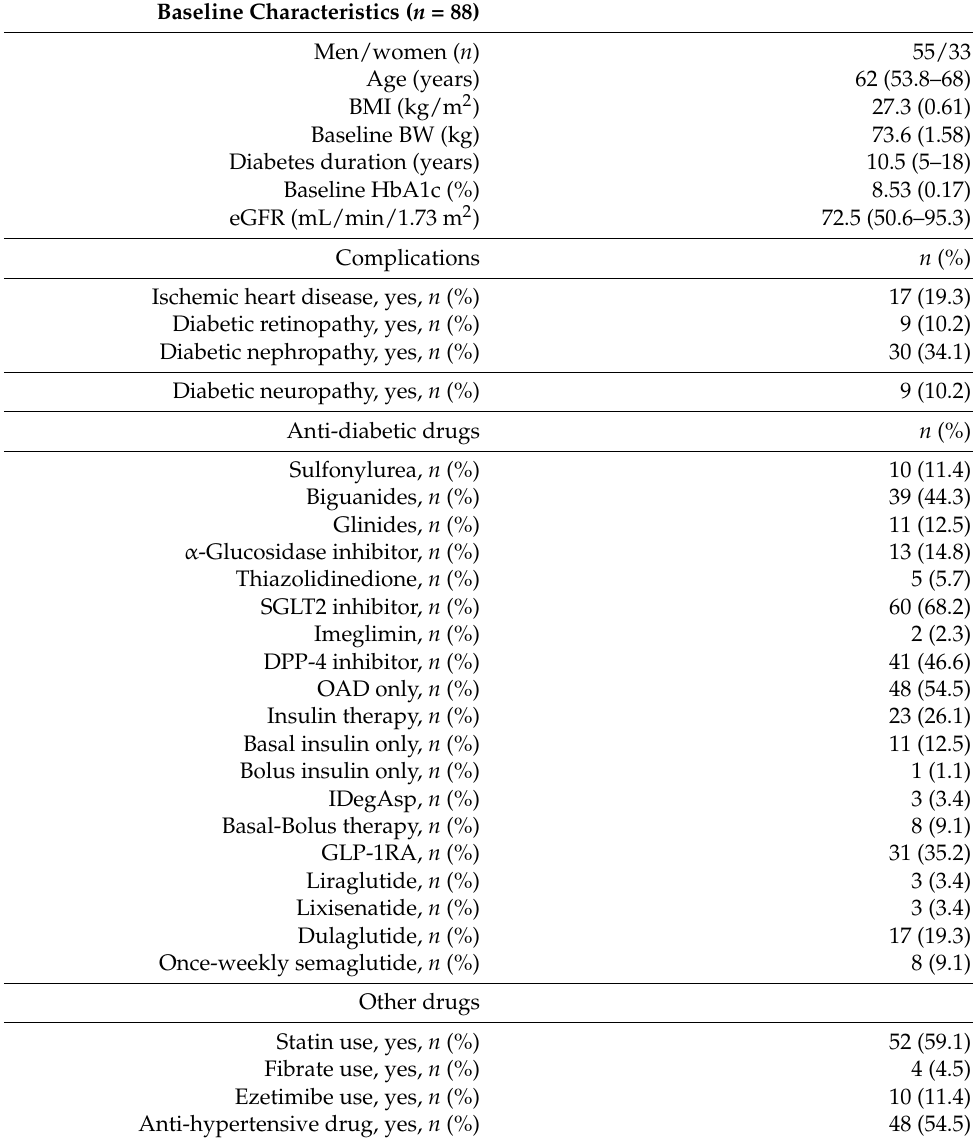
Table 1. Baseline demographic and clinical